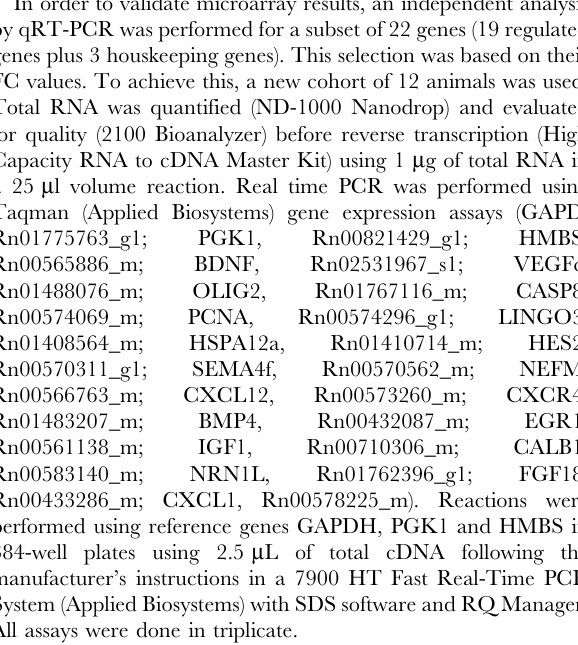
Table S1 Differentially expressed genes in the core at